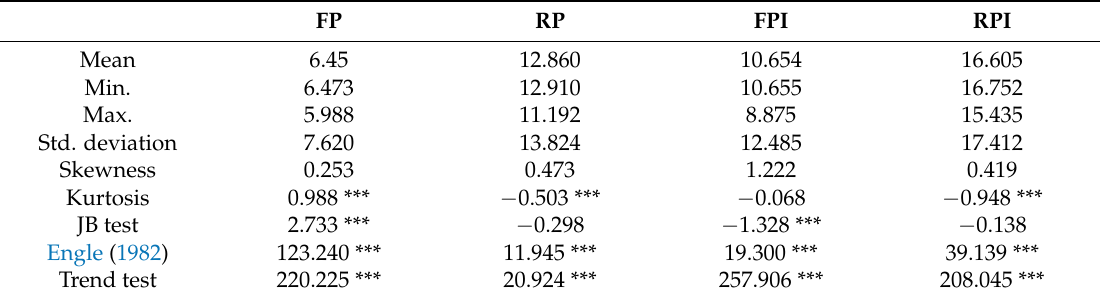
Table 2. Unit root and stationary tests.